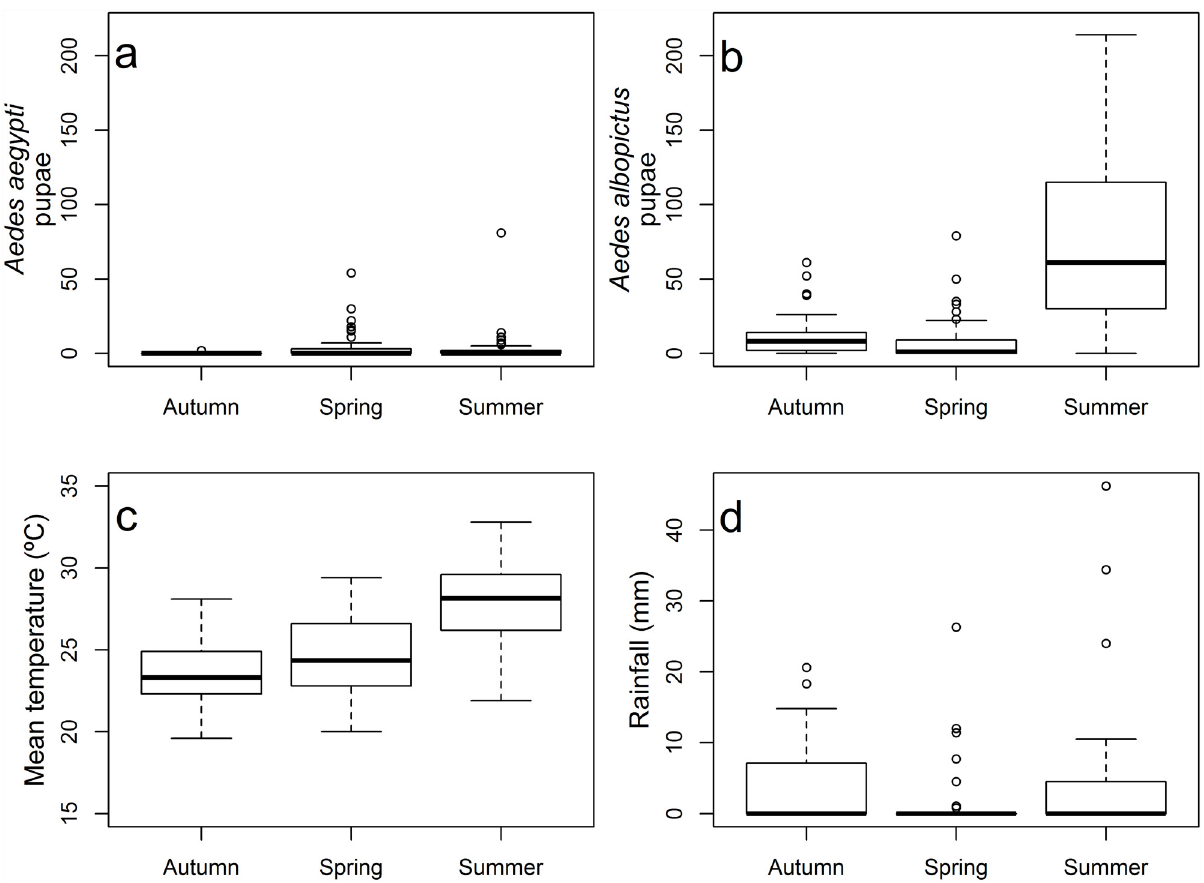
Fig 2. Pupal productivity and Climate data during the colonization period. Pupal productivity of Ae . aegypti (a) and Ae . albopictus (b), mean daily temperature (c) and daily rainfall (d) during the 30-day period of colonization in the Autumn, Spring and Summer.